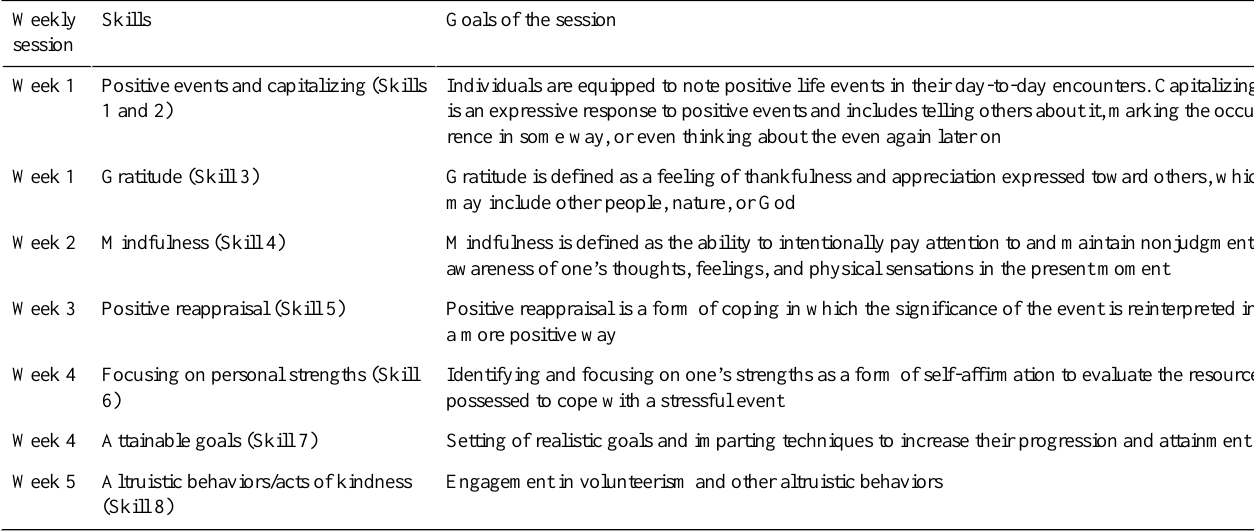
Table 1. Positive psychology skills imparted in the 5-week internet-based intervention. Goals of the